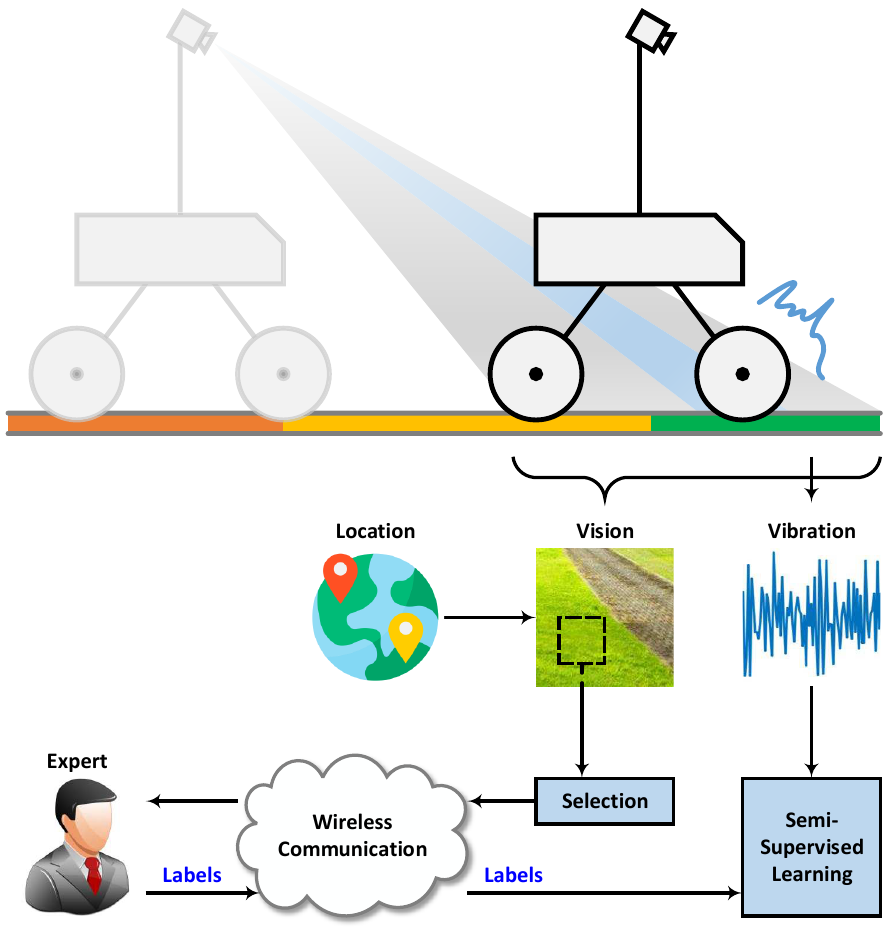
Figure 1. Illustration of the terrain classification